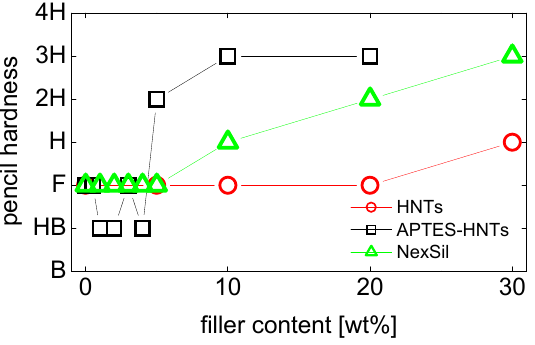
Figure 4. Pencil hardness versus degree of loading for non-silanized HNTs (circles), silanized HNTs (squares) and silica spheres